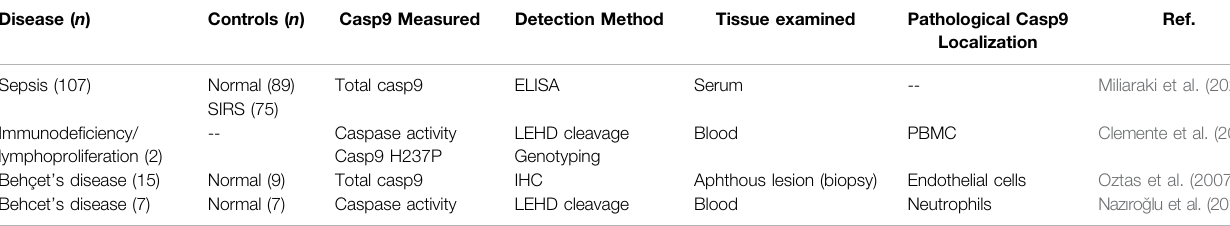
TABLE 5 | Studies reporting altered levels of caspase-9 in autoimmune